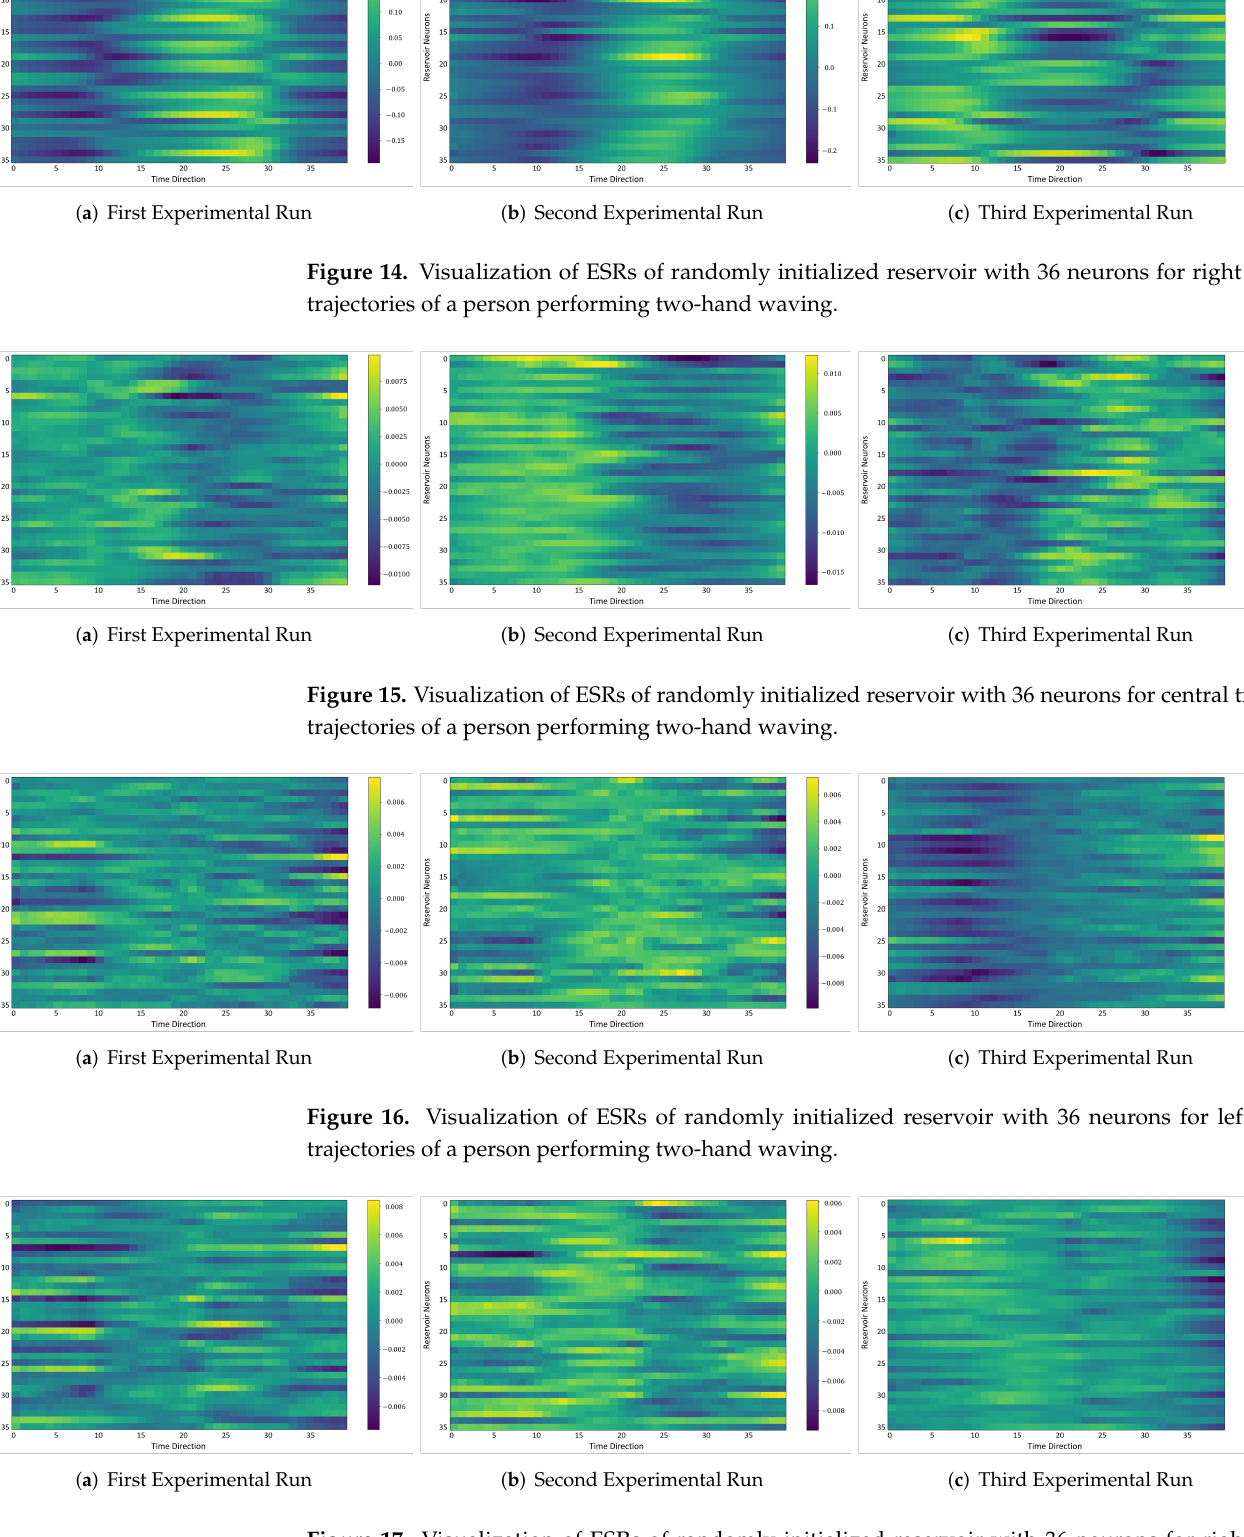
Figure 17. Visualization of ESRs of randomly initialized reservoir with 36 neurons for right leg trajectories of a person performing two-hand